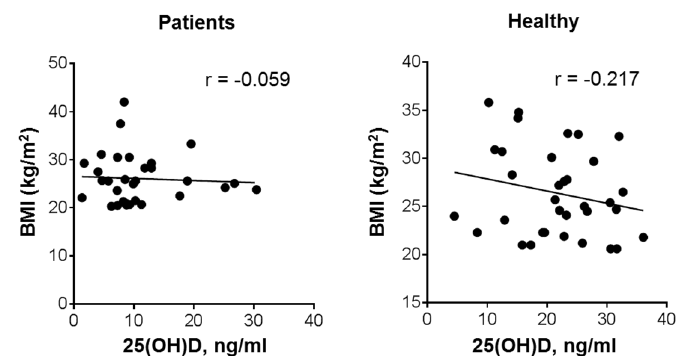
Figure 3. Relationship between plasma 25(OH)D levels and BMI in patients with leukemia and healthy subjects. Bivariate (Pearson) correlation analysis (31 patients and 34 healthy volunteers); r, correlation coefficient.